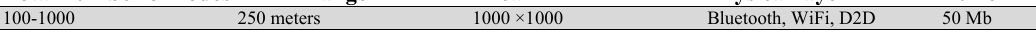
Simulation scenario Total number of nodes Range